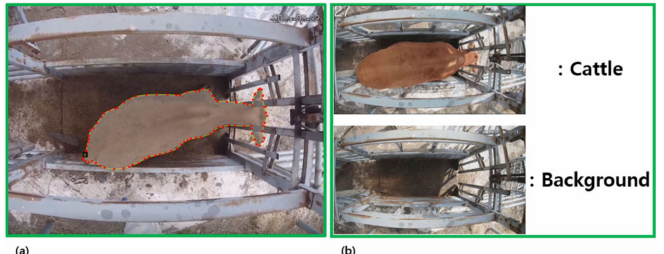
Figure 5. Difference between two ground truths; ( a ) FSS ground truth; ( b ) WSS ground truth.